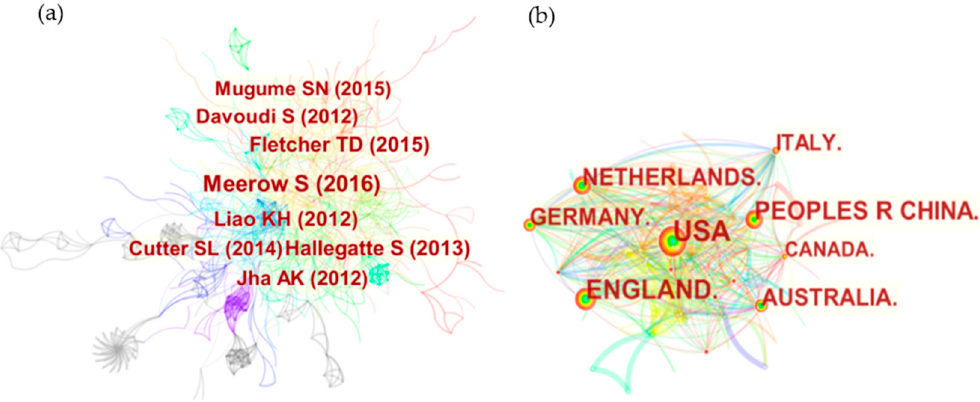
Figure 4. ( a ) Author-co-citation analysis from 1999 to 2021; ( b ) National-cooperative analysis from 1999 to